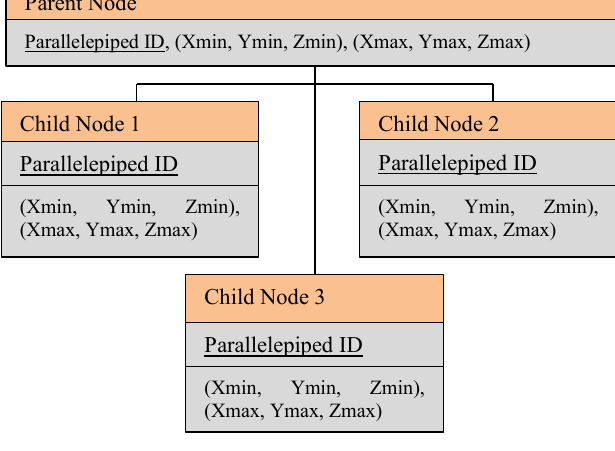
Figure 3. Clustered Hierarchical